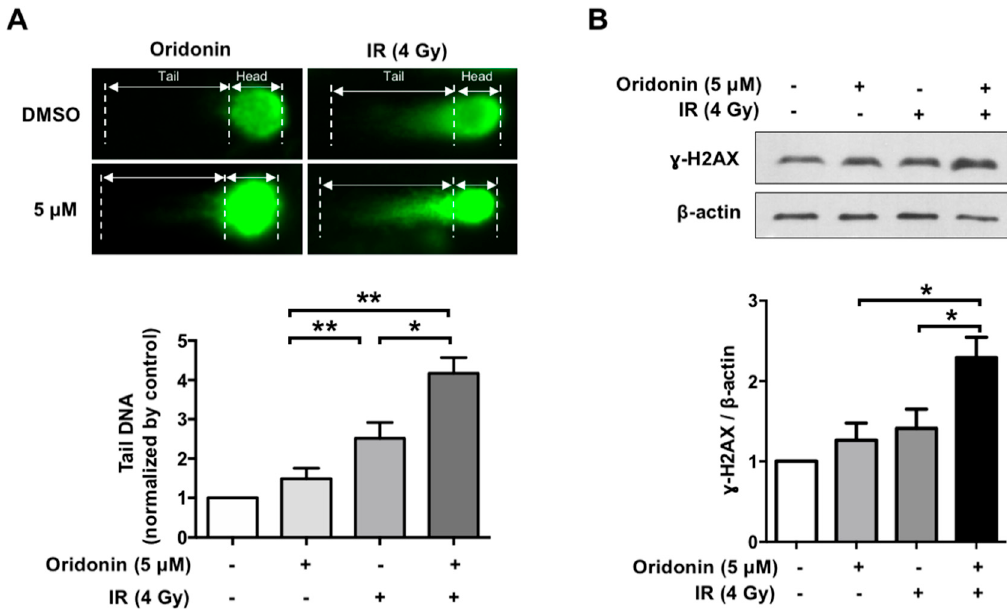
Figure 4. Effect of oridonin on radiation-induced DNA damage. ( A ) Representative images and quantification of DNA comet assays. Comet tail sizes were measured by OpenComet, an ImageJ program, and normalized to the tail intensity of the DMSO control; ( B ) phospho-histone H2AX ( γ -H2AX) protein levels were analyzed by Western blot. Ten µg of protein was loaded per lane ( upper panel ). Band intensity was quantified by ImageJ and normalized to control levels (white bar, bottom panel ). Data are representative of more than three independent experiments and values are expressed as means ± SEM; * p < 0.05 and ** p < 0.01. DMSO, dimethyl sulfoxide.